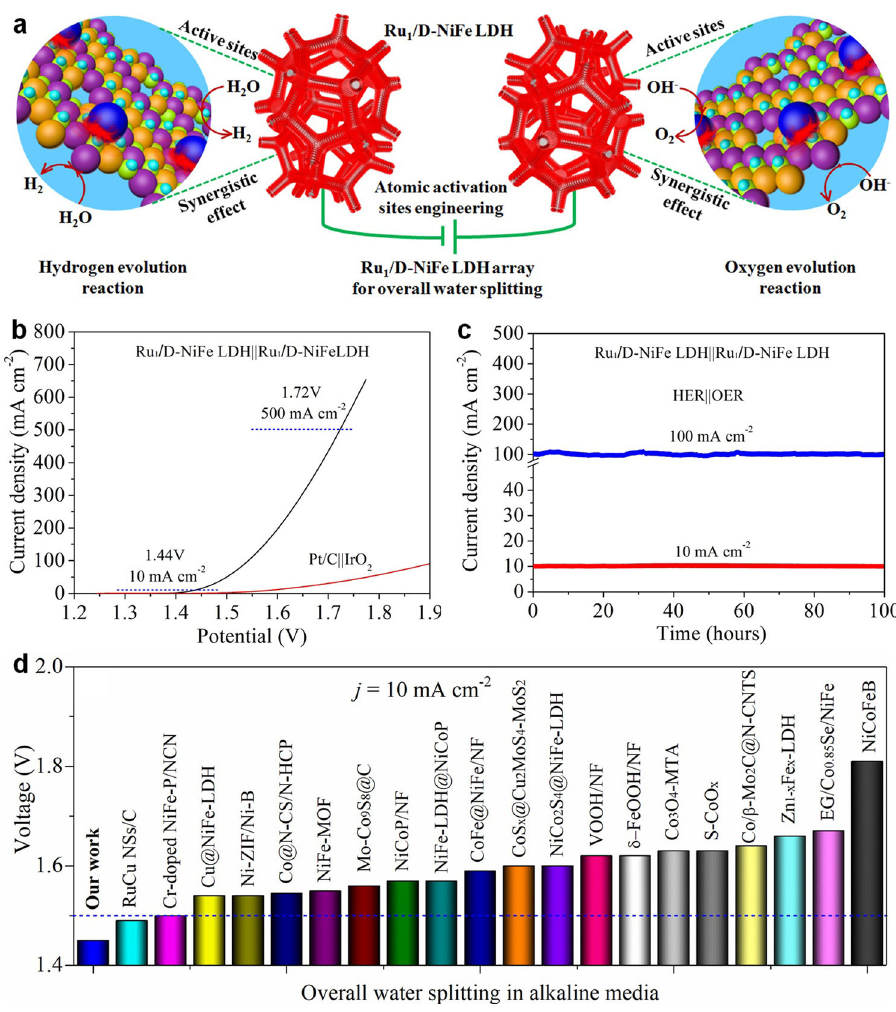
Fig. 5 Electrocatalytic performance for overall water splitting. a Schematic diagram of water splitting in a two-electrode con fi guration, ( b ) polarization curves by two-electrode system, c chronoamperometric test of Ru 1 /D-NiFe LDH with current densities of 10 and 100 mA cm − 2 at 1.44 and 1.54 V, and d comparison of the cell voltages at 10 mA cm − 2 for Ru 1 /D-NiFe LDH with reported bifunctional